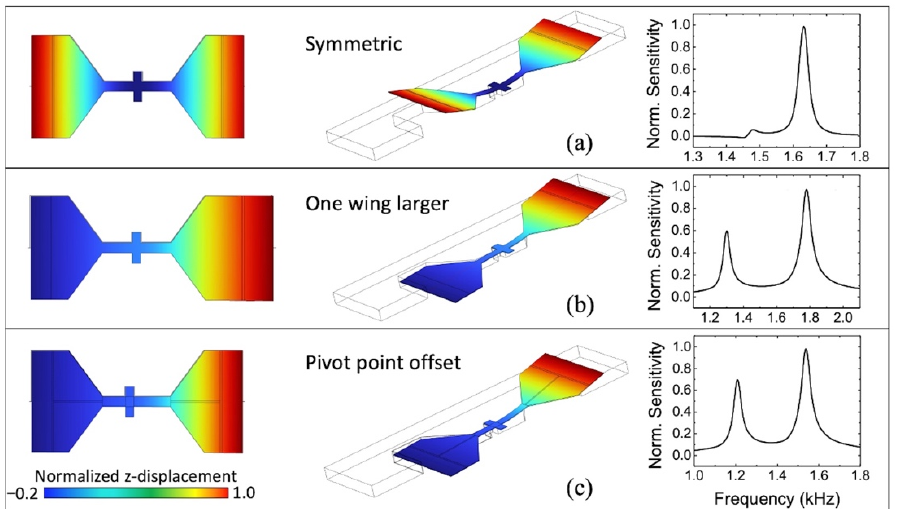
Figure 1. Schematic diagrams of two-wing MEMS sensors showing simulated frequency response in three different configurations: ( a ) symmetric bridge; ( b ) different wing sizes; ( c ) asymmetric leg pivot points (offset from the center). The vibration amplitudes are normalized for clarity.